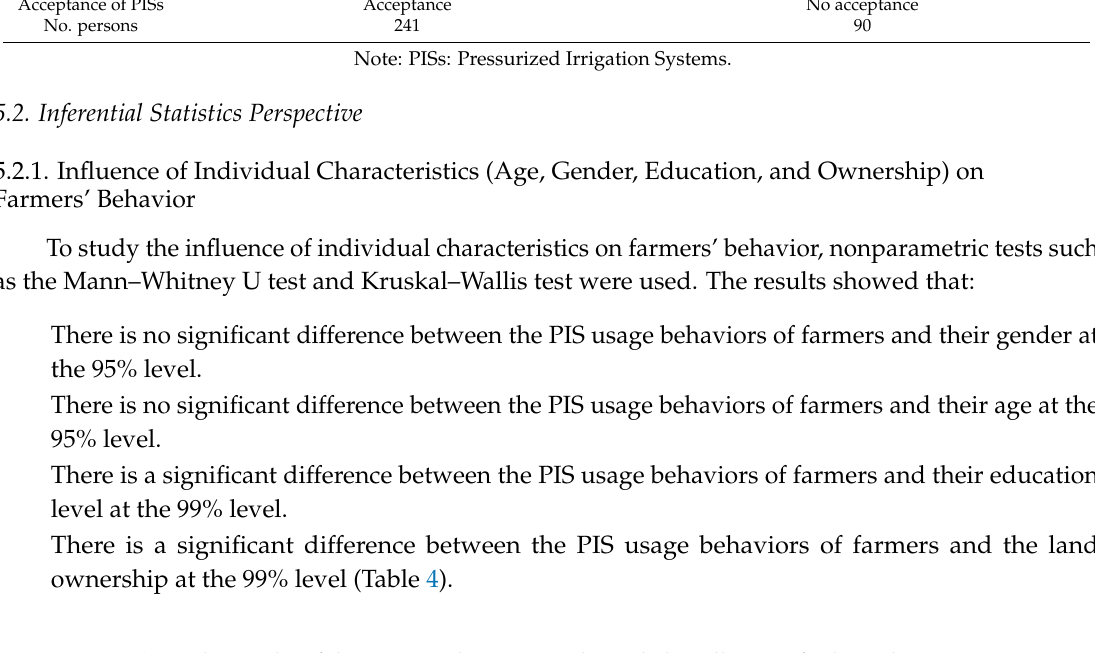
Table 4. The results of the Mann–Whitney U and Kruskal–Wallis tests for hypotheses 1–4. Hypothesis